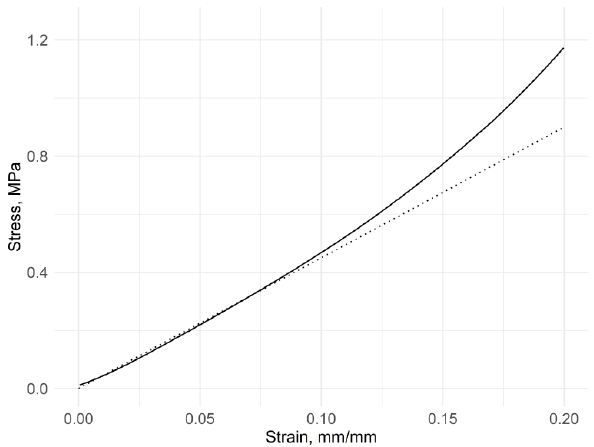
Figure 4. Stress–strain plot of a cork–rubber composite with frictional contact between loading (solid surfaces (solid line).